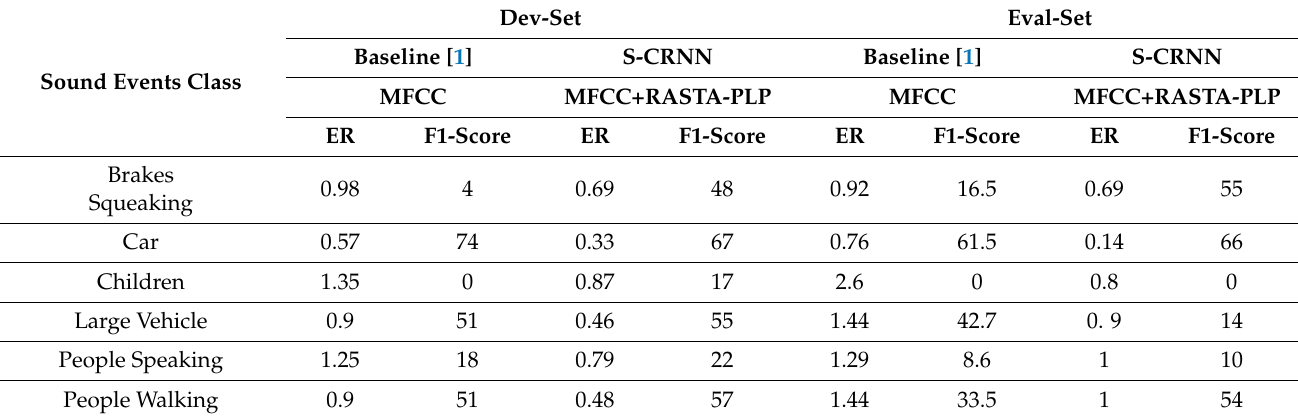
Table 6. Comparison of results using S-CRNN classifier on Dev-Set and